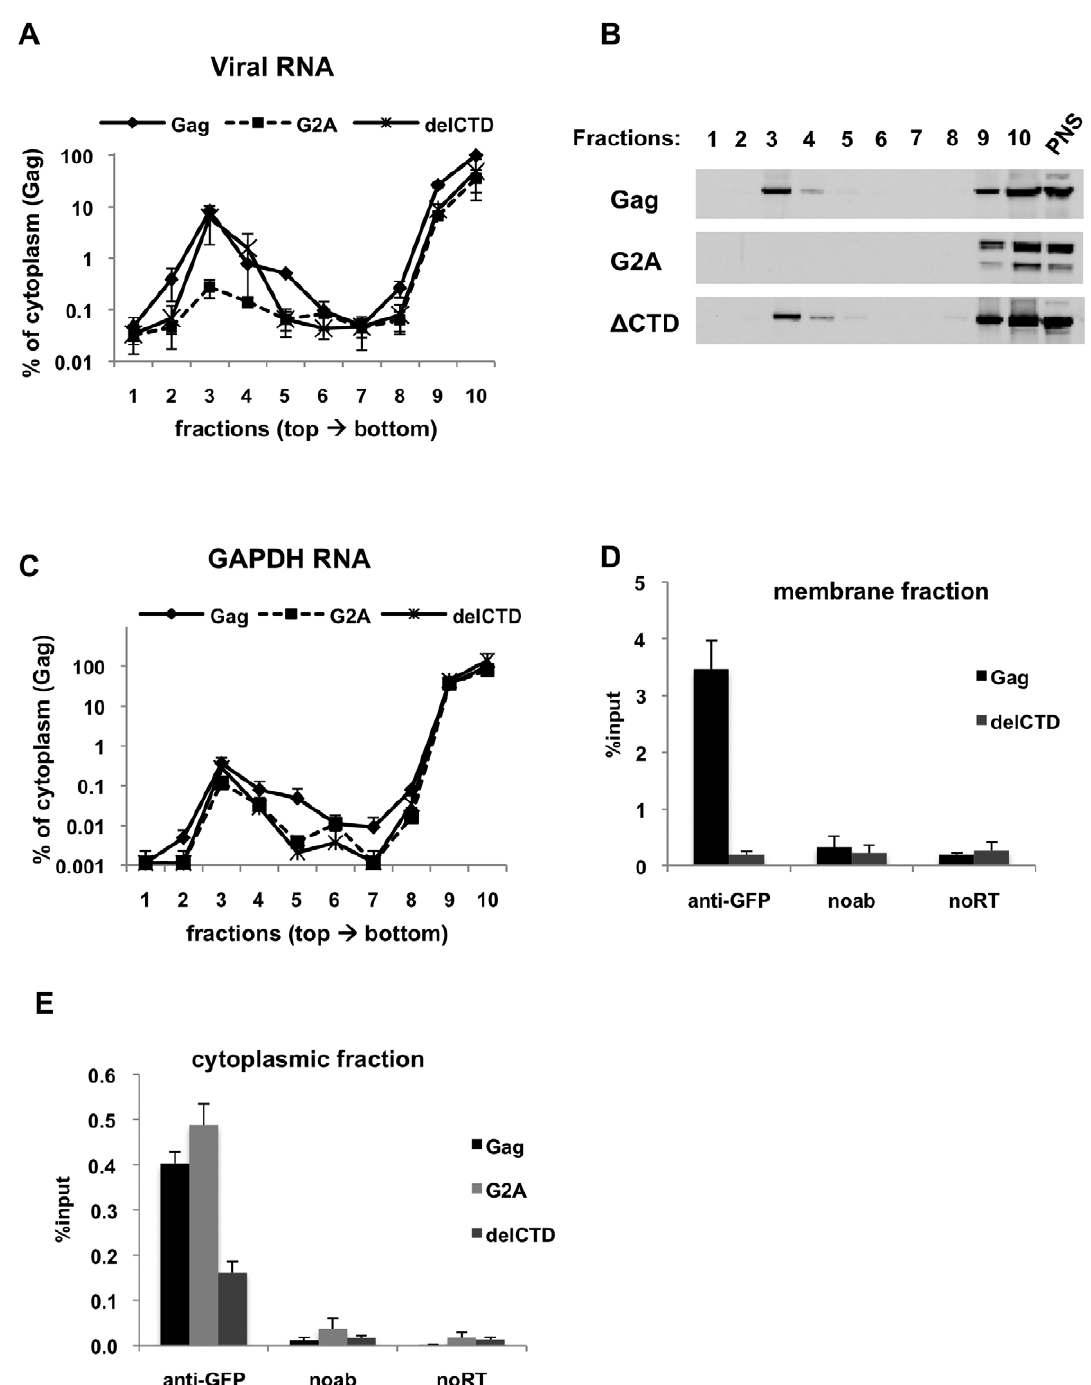
Figure 3. Immunoprecipitation of HIV genomic RNA from membrane and cytoplasmic fractions by Gag, G2A-Gag and Gag-delCTD. ( A-E ) 293T cells coexpressing V1B-MS2 and either Gag-GFP, G2A-Gag-GFP or Gag- D CTD-GFP were processed for subcellular fractionation at 24-h post-transfection. Ten fractions from the top of the membrane flotation gradient were collected. Total RNA and proteins from these fractions were isolated as explained in Materials & Methods. ( A and C ) V1B-MS2 (A) and GAPDH (C) RNA in fractions were quantitated by qRT-PCR. Data is represented as the relative number of copies of cDNA with as compared to the tenth, cytoplasmic fraction of Gag-GFP sample that was arbitrarily set to a value of 100%. ( B ) Western blot analysis of Gag-GFP, G2A-Gag-GFP and Gag- D CTD-GFP in sucrose fractions and in post-nuclear supernatant (PNS) using anti-HIV-1 MA antibodies. ( D and E ) After subcellular fractionation, immunoprecipitations from the membrane (D) and cytoplasmic (E) fractions were performed using anti-GFP antibodies as explained in Materials & Methods. Parallel immunoprecipitations were carried in the absence of antibodies (noab). Immunoprecipitated V1B-MS2 RNA is quantitated by qRT-PCR and is represented as a fraction of input material prior to immunoprecipitation (% input, [D, E]). Data in (A, C, D, E) represents the average of two independent experiments where error bars indicate the range. noRT= as explained in legend to Figure 1.